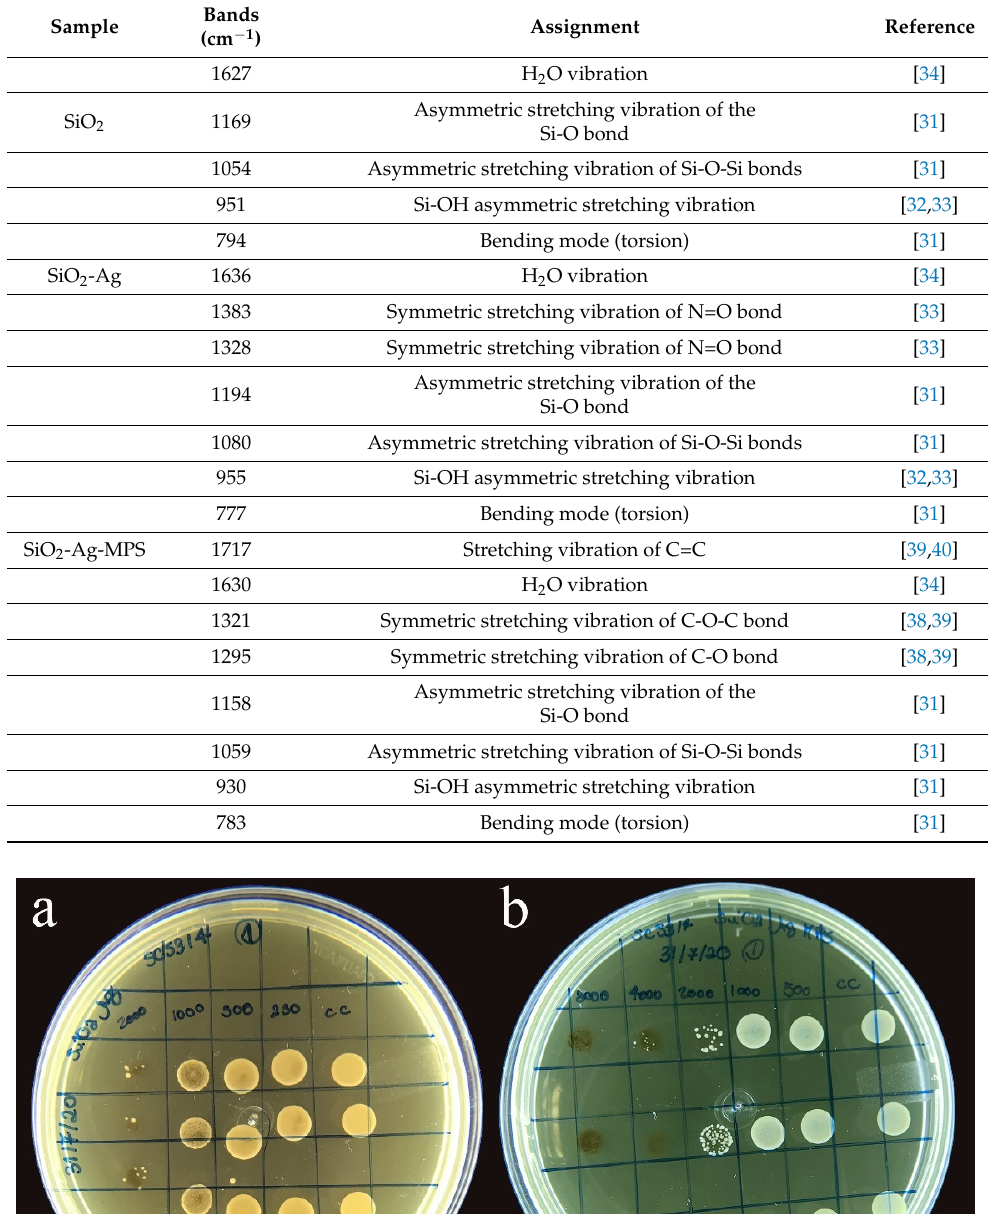
Table 4. Assignment of FT-IR bands for SiO 2 , SiO 2 -Ag, and SiO 2 -Ag-MPS samples.